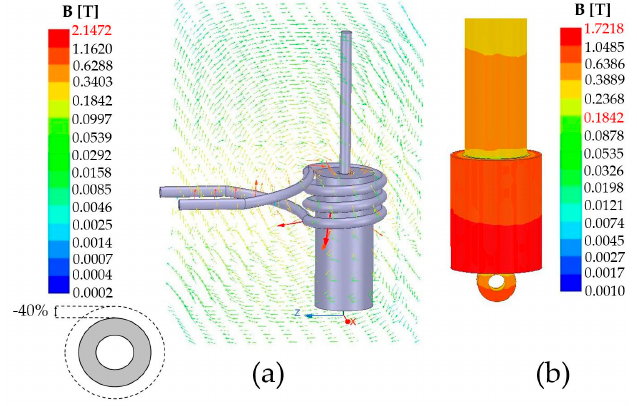
Figure 17. The magnetic flux density ( B ) with N = 3 by decreasing 40% Th for ( a ) an overview and ( b ) around the product. ( b ) around the product.